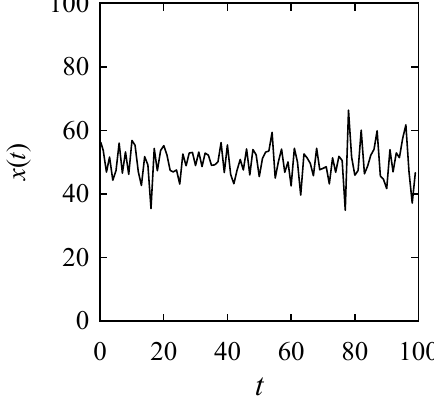
Figure A1. A given set of numerical data.